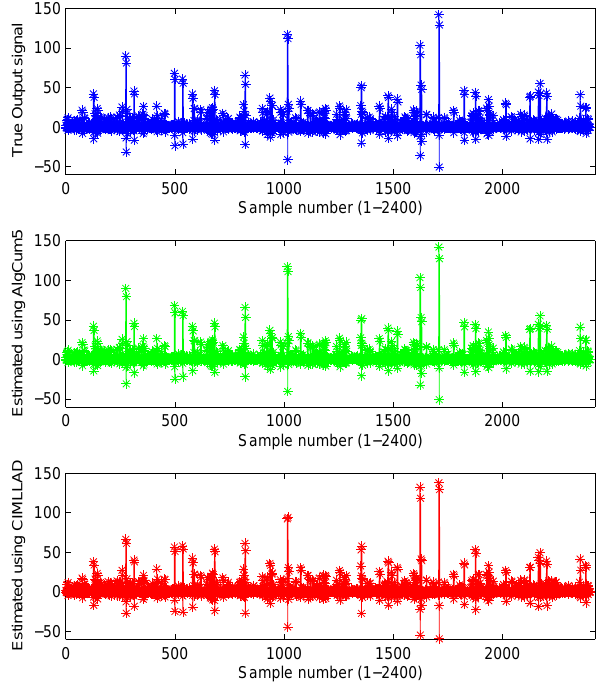
Figure 8. True and estimated output signals for System